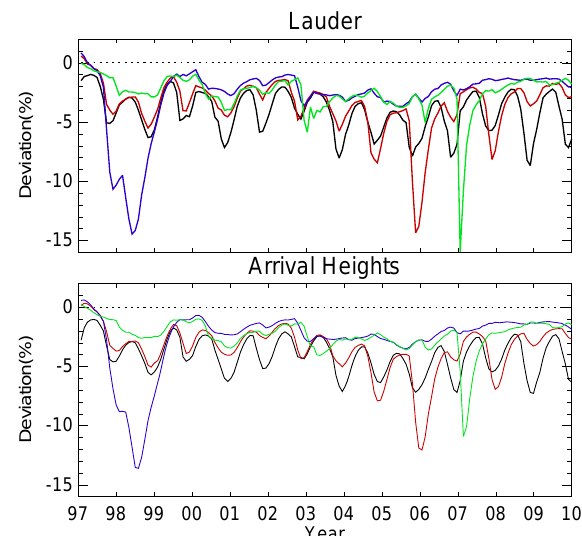
Fig. 8. Percentage differences of CO columns at Lauder and Arrival Heights, caused by 50% reductions of biomass burning emissions from southern Africa (black), South America (red), South-East Asia (blue), and Australia